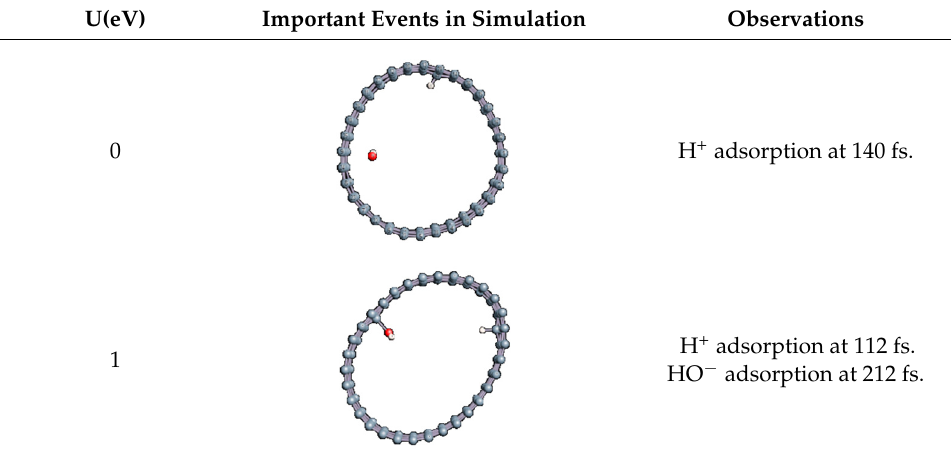
Table 3. Water molecule dissociated inside (16,0) CNT under electric bias. U(eV)